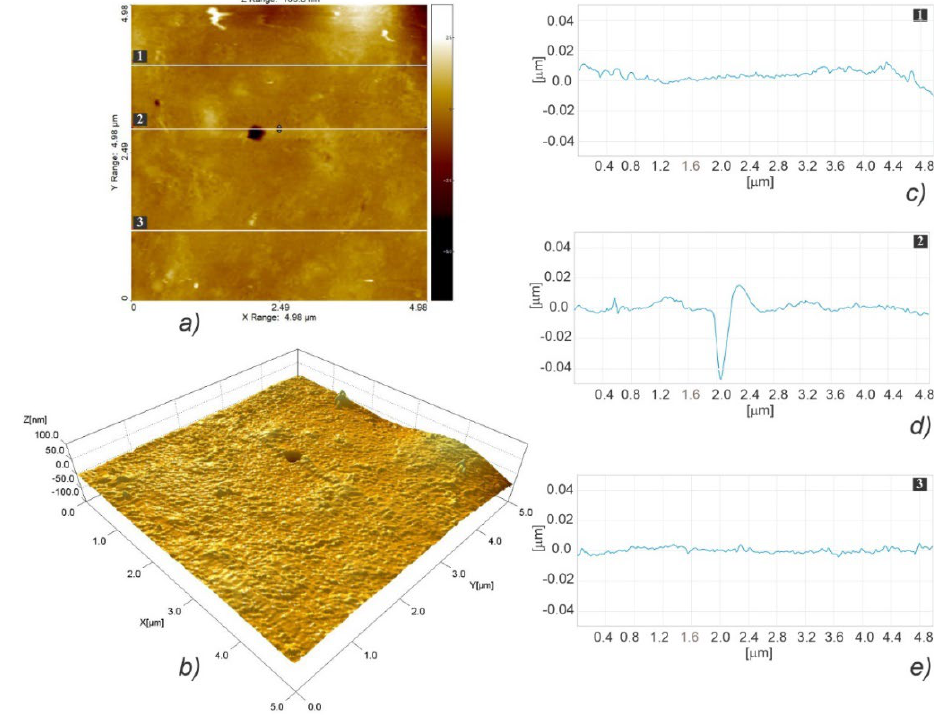
Figure 13. AFM topographic images obtained for the LLC scaffold over 5 × 5 µm area ( a , b ), and the corresponding profiles taken at locations marked with 1 ( c ), 2 ( d ), and 3 ( e ).